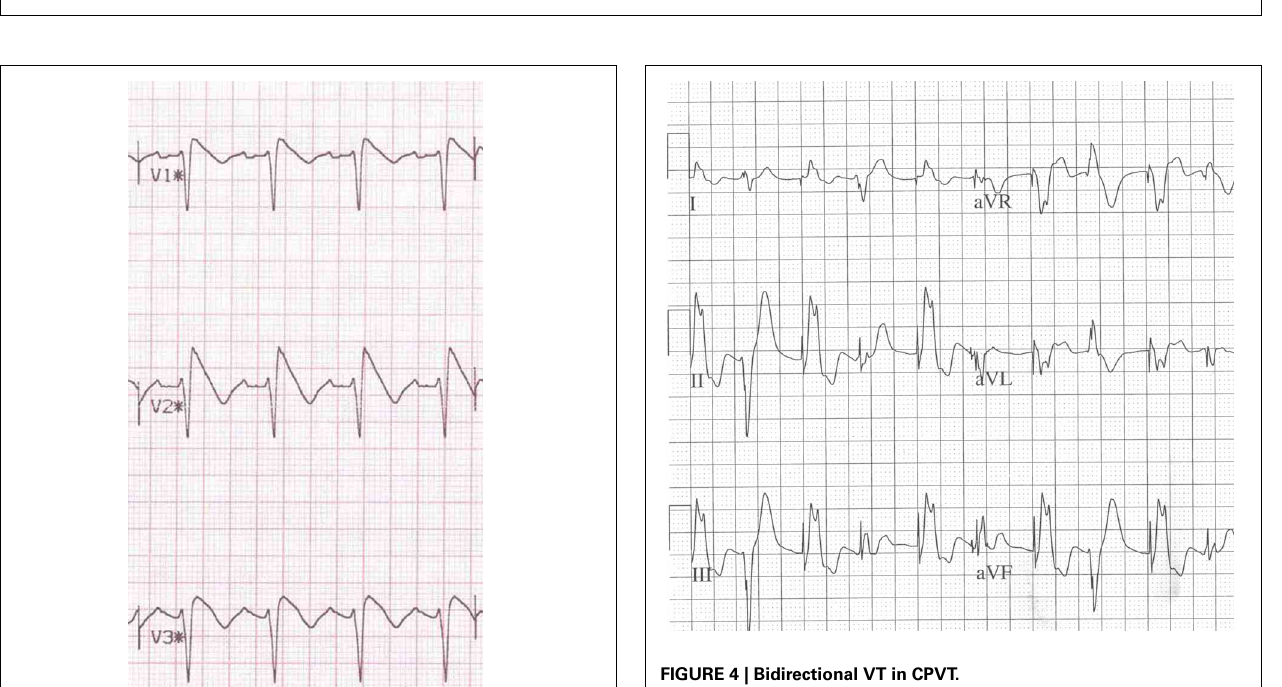
FIGURE 4 | Bidirectional VT in